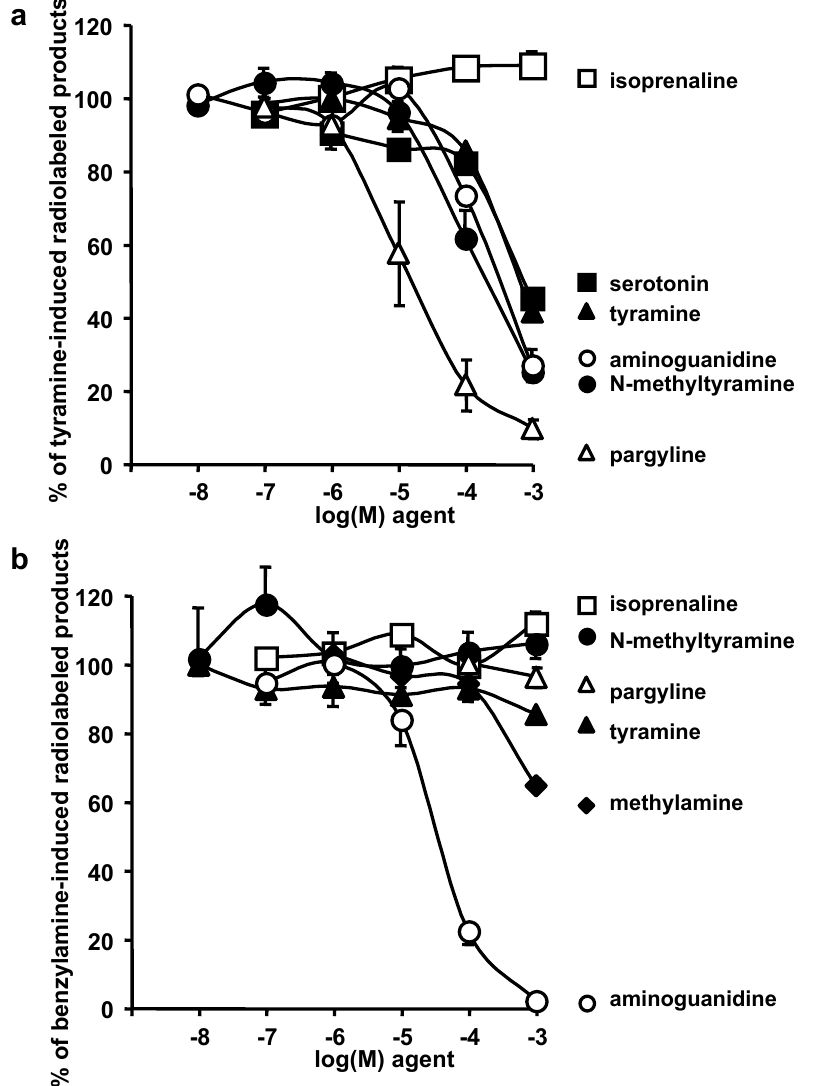
Figure 3. Influence of tyramine, NMT, and reference substrates or inhibitors on MAO and SSAO activities in human adipose tissue. ( a ) The oxidation of 0.5 mM [ 14 C]-tyramine by the MAO activity found in human AT homogenates was set at 100% in the absence of any added agent. The release of radioactive products (mainly aldehydes) derived from [ 14 C]-tyramine oxidation was almost abolished by the MAO inhibitor pargyline (open triangles), and inhibited by increasing doses of aminoguanidine (open circles), N -methyltyramine (NMT, closed circles), serotonin (closed squares), or cold tyramine (closed triangles), but not by isoprenaline (open squares). ( b ) [ 14 C]-benzylamine oxidation was not inhibited by pargyline but was abolished by the SSAO inhibitor aminoguanidine. [ 14 C]-benzylamine oxidation was not modified in the presence of isoprenaline, N -methyltyramine or tyramine, but was impaired by 1 mM methylamine (closed diamonds). Each point is the mean ± SEM from five to seven preparations of human subcutaneous adipose tissues. For each panel, no significant difference was found between tyramine and NMT.